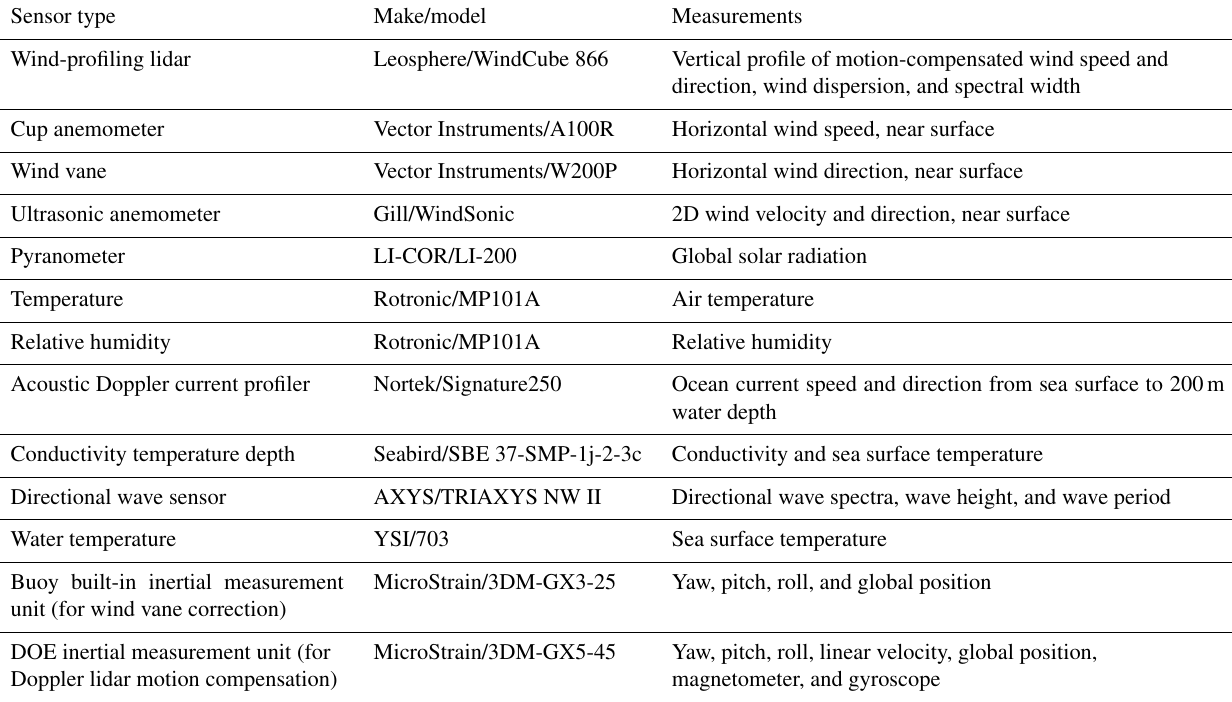
Figure 2. Observational coverage of the (a) Humboldt and (d) Morro Bay deployments, observed 100m wind roses from the (b) Humboldt and (e) Morro Bay deployments, and Weibull fits to wind speed observations from the (c) Humboldt and (f) Morro Bay deployments. PDF: probability density function. Table 1. Description of instrument manufacturer and